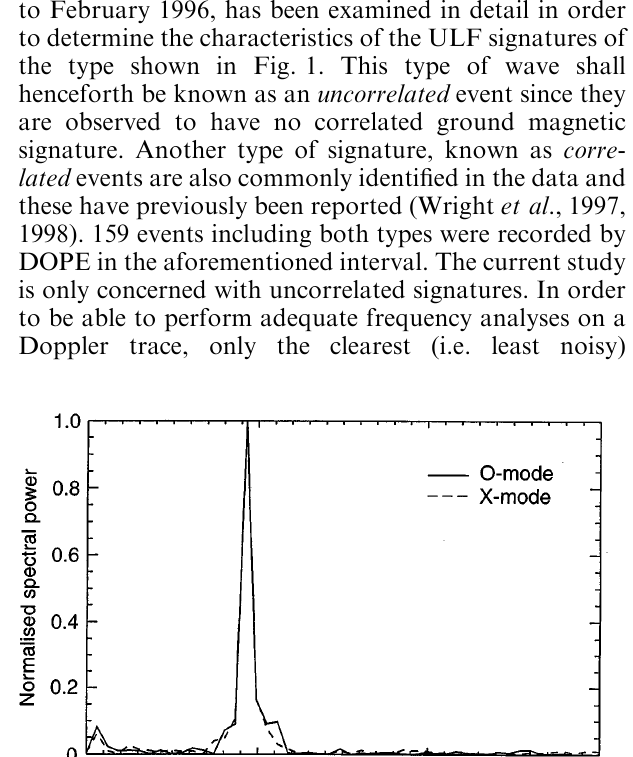
Fig. 1a–d. HF Doppler a O- and b X-mode traces for the ULF wave event which occurred on 2 September, 1995. A simultaneous ground magnetic signature is ab- sent in both c X- and d Y- component data recorded at Tromsø ( TRO ), Norway and So-